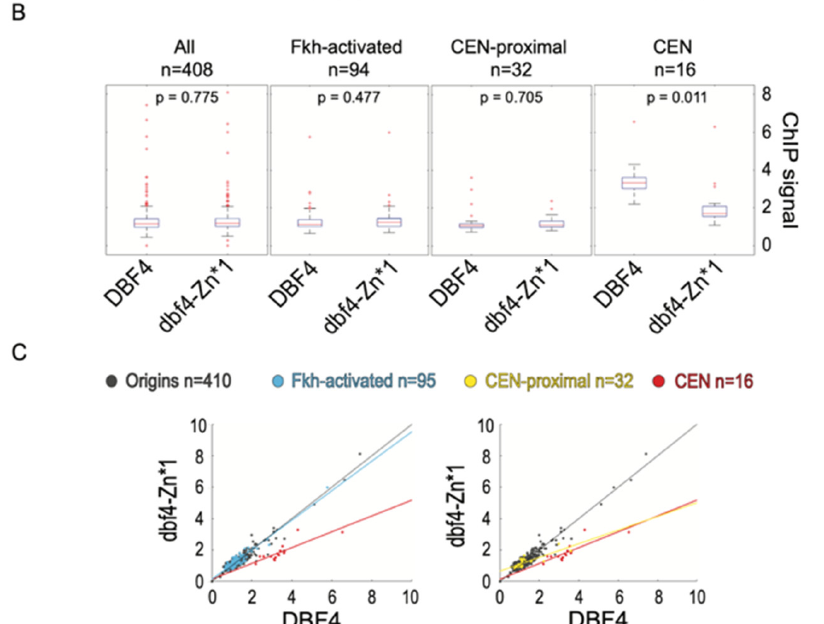
Figure 5. Dbf4-Zn* is defective in its recruitment to CENs. Strains EAy1 ( 3xFLAG-DBF4 ) and EAy2 ( 3xFLAG-dbf4-Zn*1 ) were synchronized in G1 phase and subjected to ChIP-seq analysis. ( A ) Heatmaps of averaged ChIP-seq values across 10kbp regions centered on origins (n = 408 because two rDNA origins removed), origin sub-groups, or CENs. ( B ) Boxplot distributions of ChIP-seq values for 500 bp windows centered on the indicated features, subjected to two-sided t-tests. ( C ) Two-dimensional scatter plots of ChIP-seq values for 500 bp windows centered on the indicated features, showing lines of best fit for origin sub-groups and CENs.